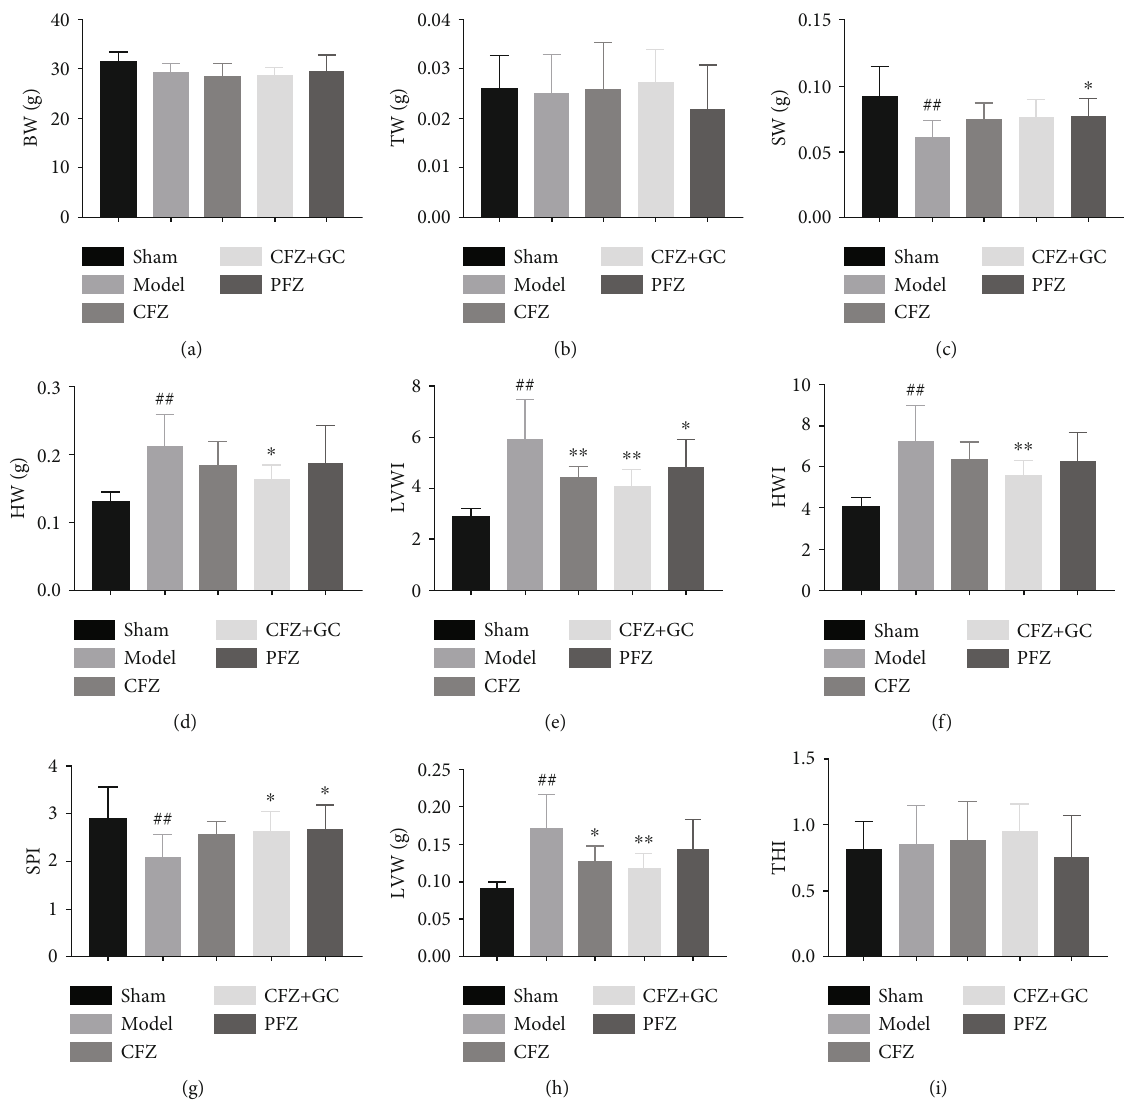
Figure 4: Mass indices in mice of each group: (a) BW: body weight; (b) TW: thymus weight; (c) SW: spleen weight; (d) HW: heart weight; (e) LVW: left ventricle weight; (f) THI: thymus weight index; (g) SPI: spleen weight index; (h) HWI: heart weight index; (i) LVWI: left ventricle weight index. Sham group ( n = 7 ), model group ( n = 7 ), crude Fuzi (CFZ) group ( n = 5 ), CFZ combined with Glycyrrhiza (CFZ+GC) group ( n = 9 ), and prepared materials of Fuzi (PFZ) group ( n = 9 ). All data are presented as the mean ± SD . ## P < 0 : 01 versus the sham group; ∗ P < 0 : 05 and ∗∗ P < 0 : 01 versus the model